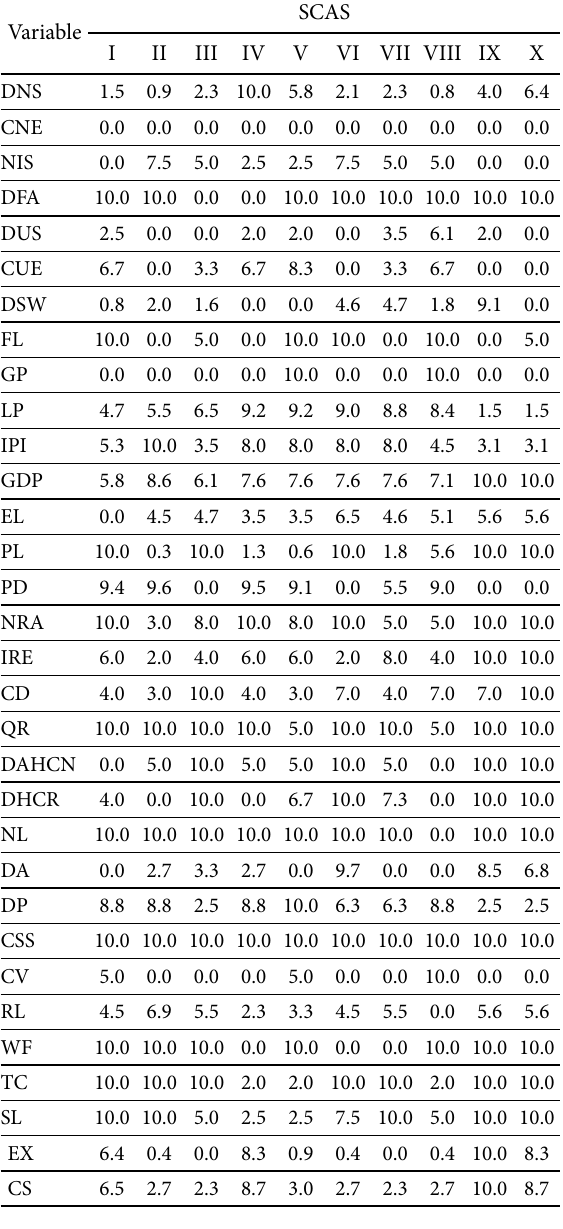
Table 4. Compilation of Standardised